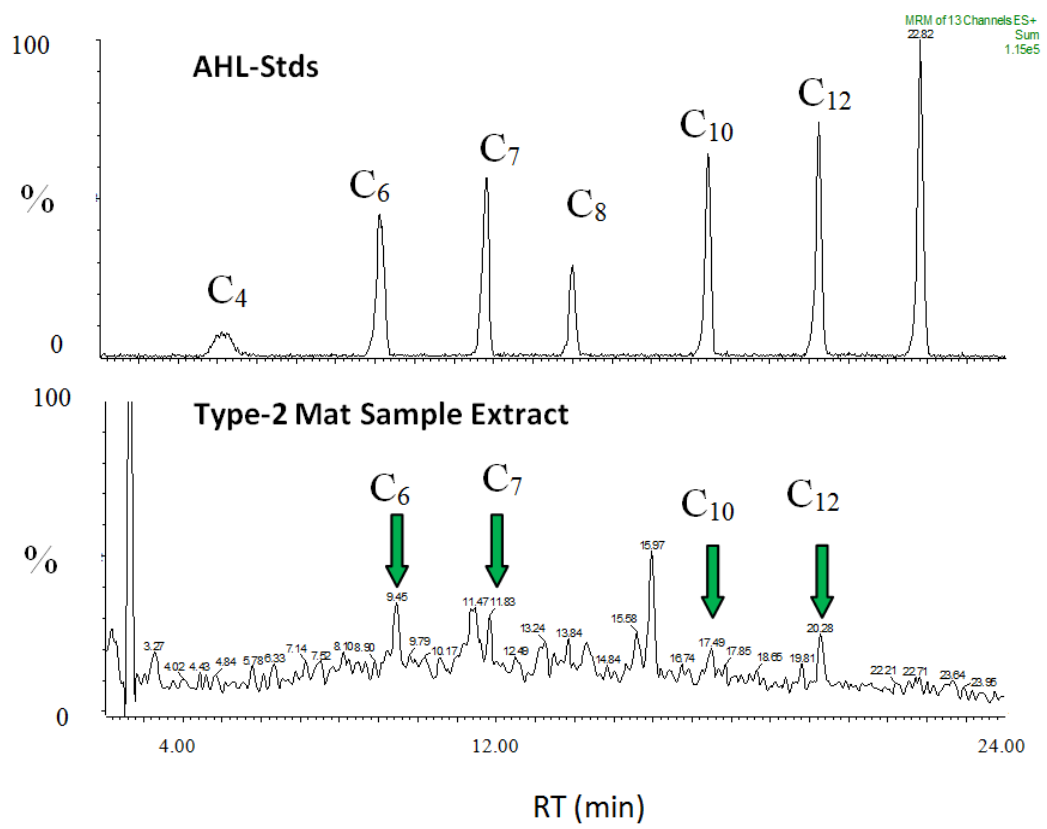
Figure 7. Spectra showing AHLs extracted from Type 2 mats, and AHL standards. Samples are separated using LC/MS. Peaks are shown as a relative percent ( y -axis), while x -axis shows retention time (RT), expressed in